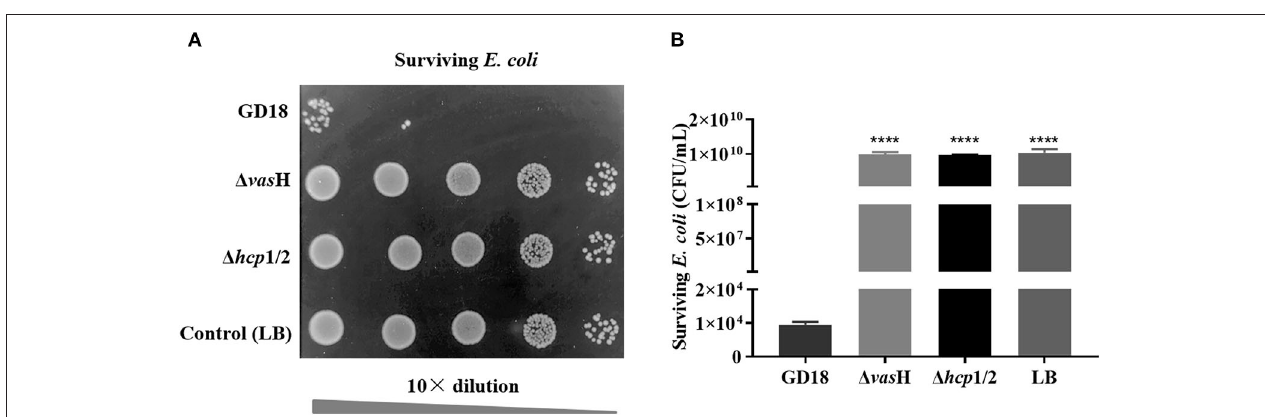
FIGURE 7 | VasH contributes to the bactericidal effect of A. hydrophila. The survival of Escherichia coli was determined post-incubation with different A. hydrophila strains as indicated. (A) The surviving E. coli cells were serially diluted and determined on the LA plates supplemented with kanamycin. Control indicates incubation of E. coli with sterile LB medium alone. 1 hcp 1/2 mutant group was set as the T6SS defective control group. (B) The data was presented as the mean ± SD of three independent experiments. Statistical significance was calculated by unpaired t - test. **** p < 0.0001.